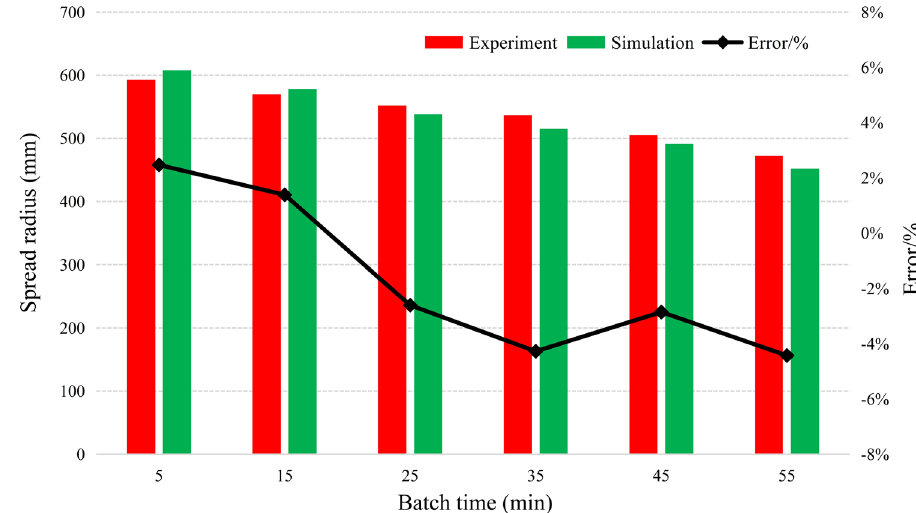
Figure 14: Self - compacting spread diameter of mortar under di ff erent batch